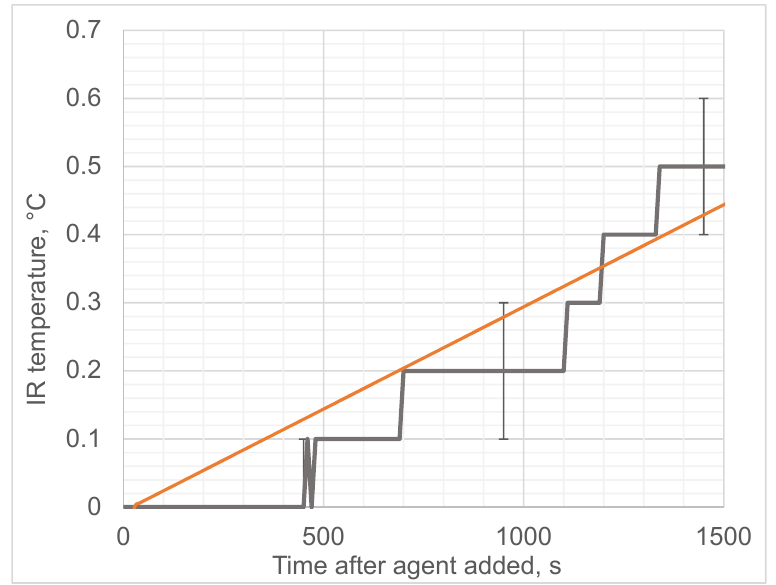
Figure 5 . Thermodynamic temperature during alcohol-induced denaturation. Black solid line denotes experimentally observed brightness temperature; orange line denotes approximation (slope).